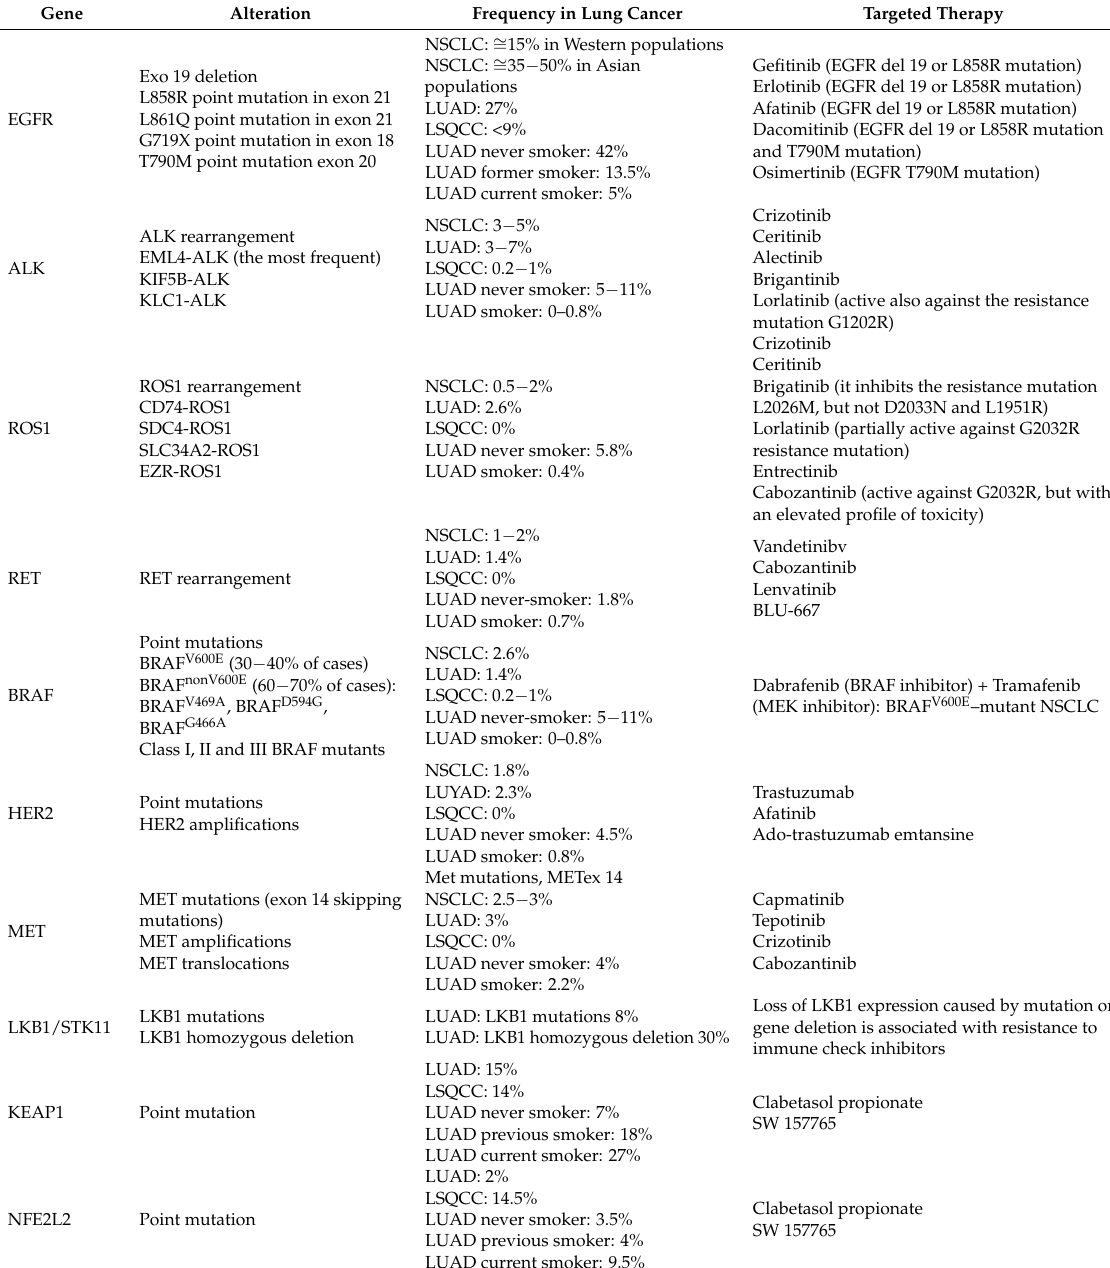
Table 3. Druggable mutations mainly observed in lung adenocarcinomas